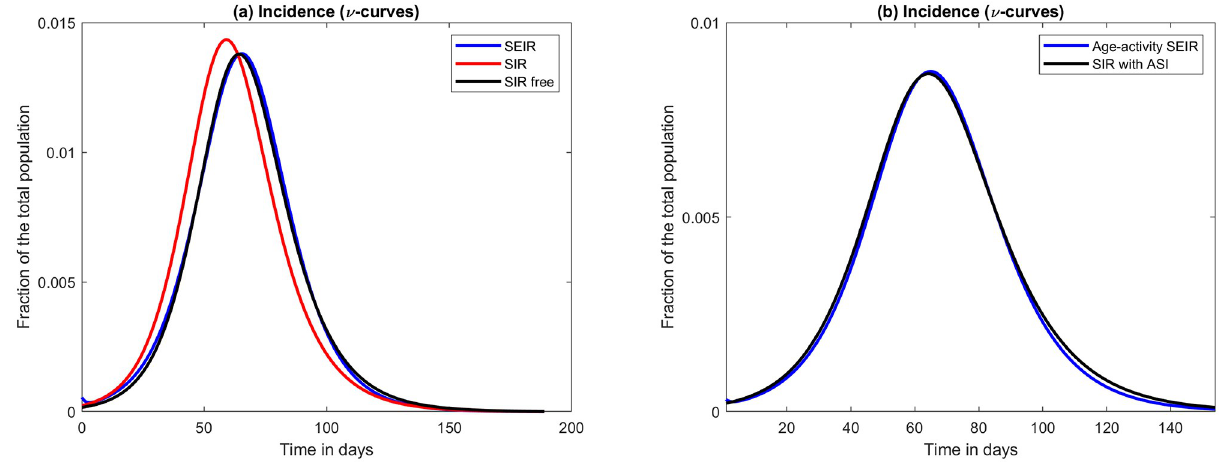
Fig 3. Approximations using SIR with ASI. (a) SEIR with R 0 = 1.66 and T and finally SIR with a 1% lower R 0 , same T generation (black). (b) Age-activity stratified SEIR with R 0 = 1.66 and T infectious + T infective = 7 (blue); SIR using the same T but an ASI of 25% and slightly different R 0 generation